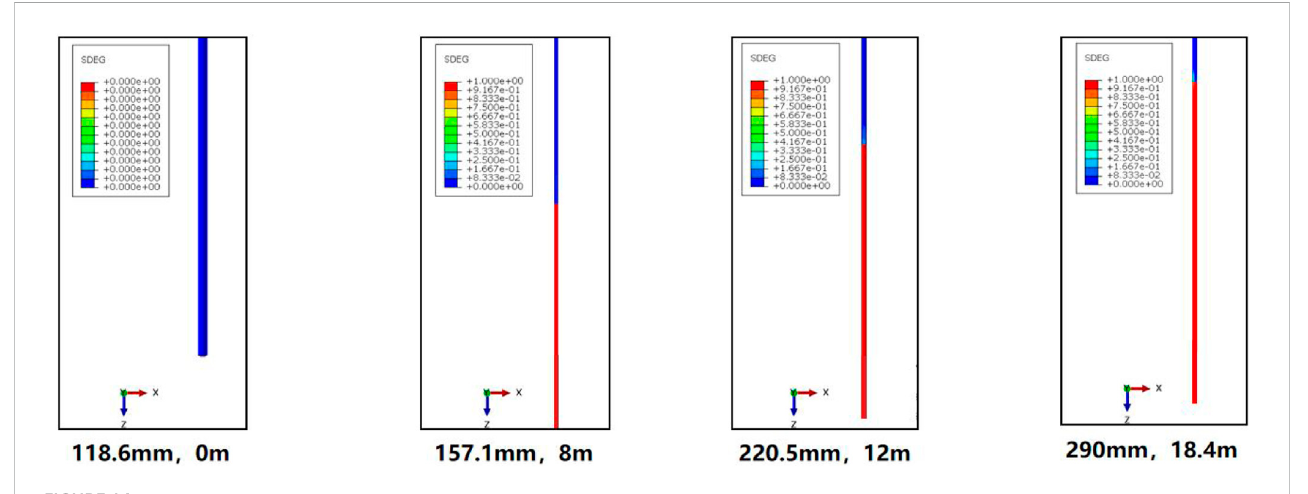
FIGURE 14 The strip length varies with the cement plug